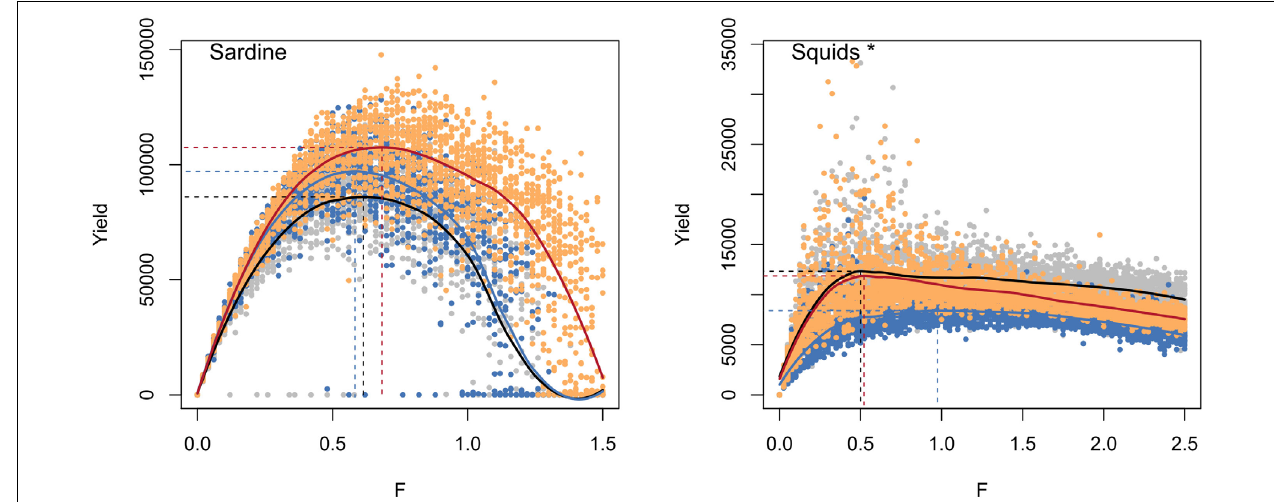
FIGURE 1 | Evolution of yield with fishing mortality rate (F) for each species, under historical conditions (gray and black), and under climate change scenarios RCP 4.5 (blue) and RCP 8.5 (orange and red). Dots correspond to the simulated yield (using 30 replicates) and the line corresponds to the adjusted loess function. Horizontal dashed lines indicate MSY, and vertical dashed lines indicate F MSY for most species and F 95 MSY for species for which the curve shows a plateau (indicated by * next to species name).